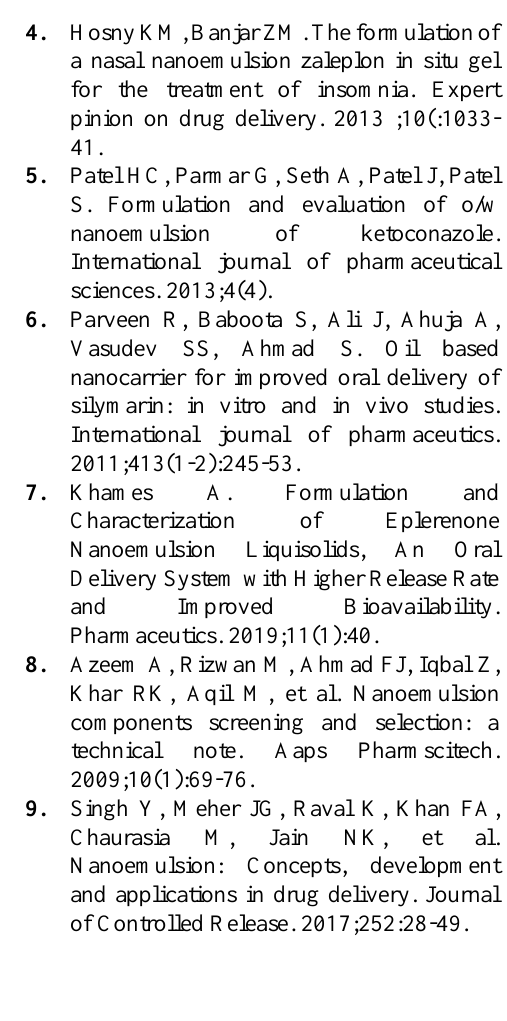
Figure 12. FE-SEM of optimum NS-7 formulation